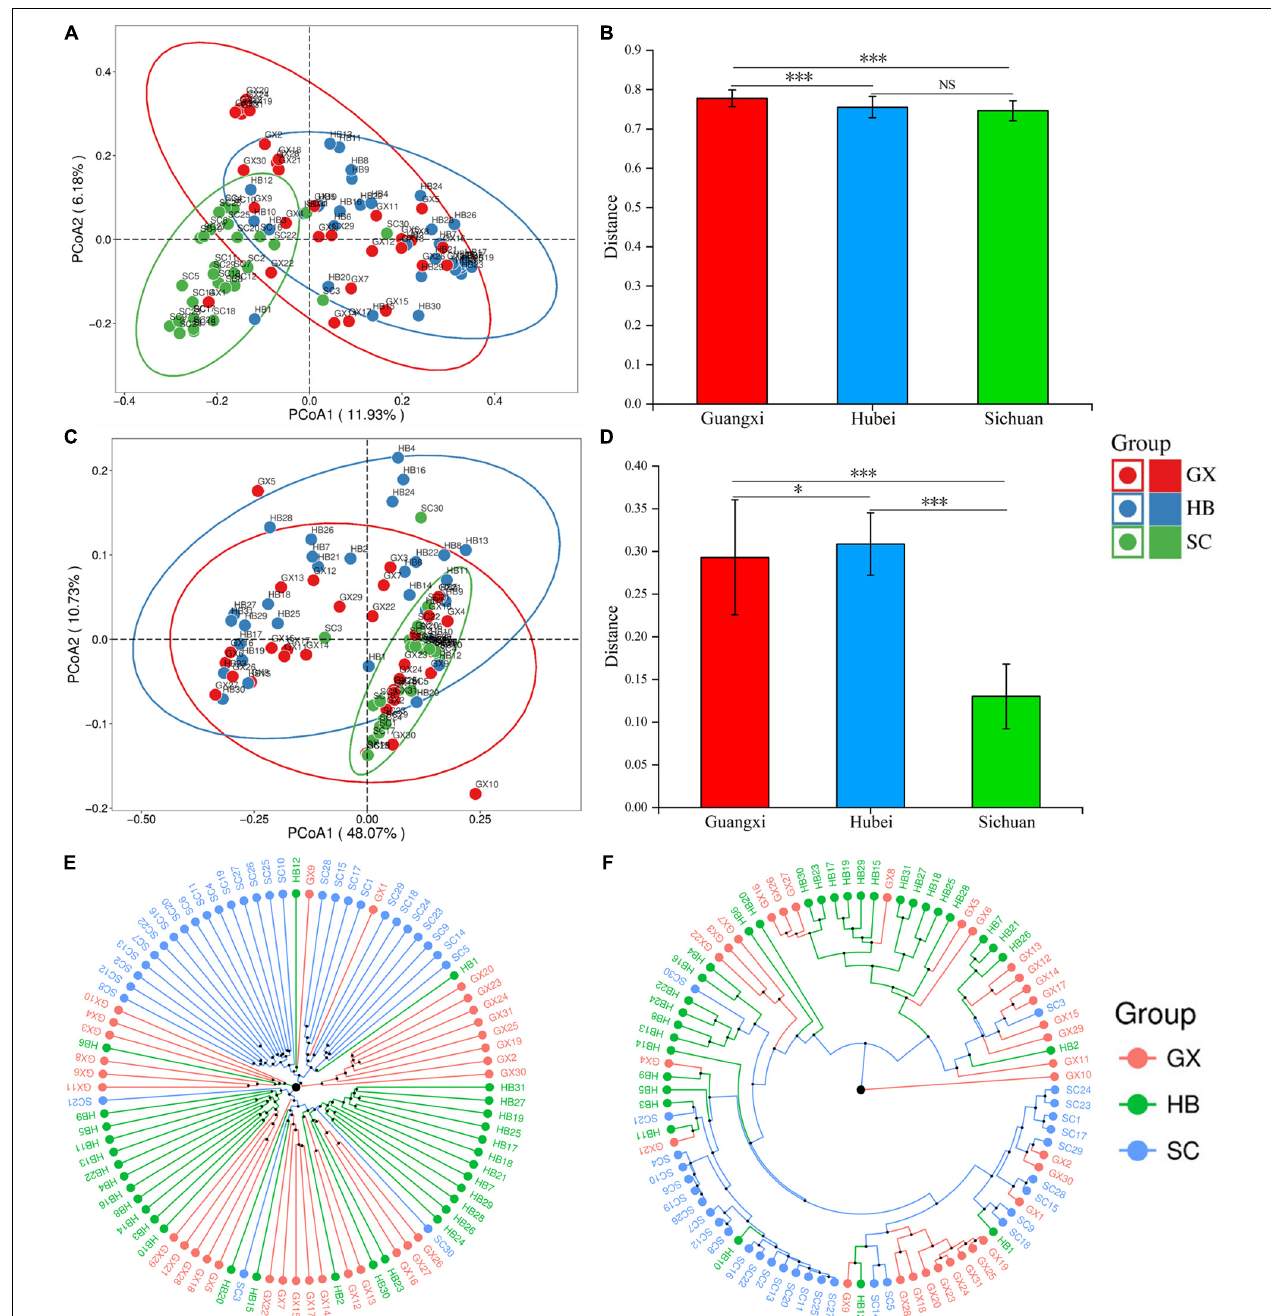
FIGURE 3 | Unweighted (A) and weighted (B) PCoA score plots based on principal components 1 and 2. (C,D) Euclidean distance clustering analysis; clustering of rice wine koji samples based on unweighted (E) and weighted (F) UniFrac distances. Significant differences are represented by ***(0.0001 ≤ p < 0.001), *(0.01 ≤ p < 0.05), and ns ( p ≥